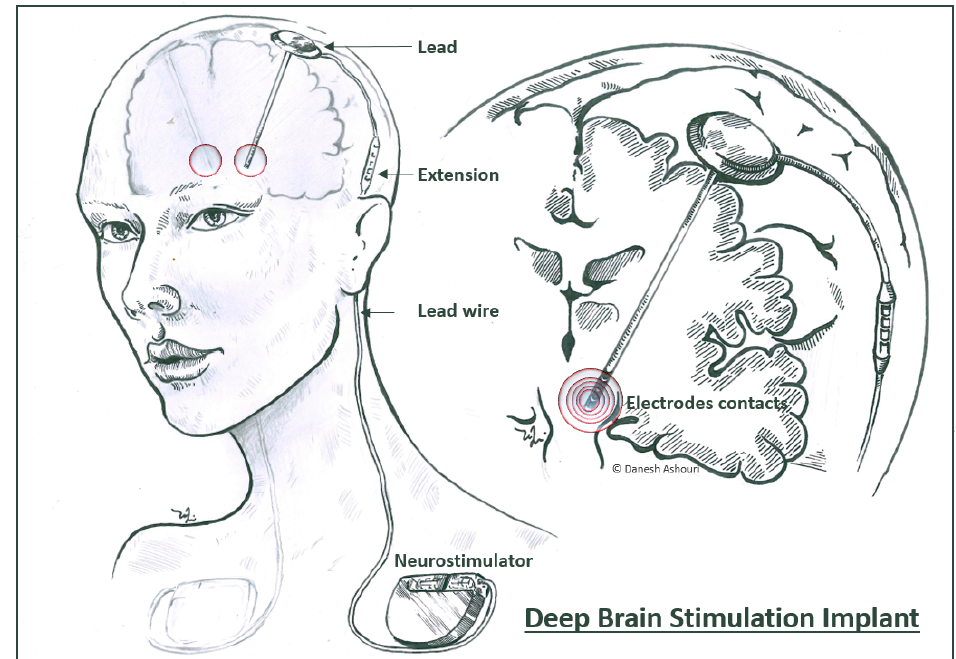
Figure 1. Illustration of a deep brain stimulation device implanted in a patient. A deep brain stimulation implant consists of four main components; electrode contacts, lead, lead wire, extension part and the implantable pulse generator (IPG or neurostimulator). A conventional DBS probe is featured with four annular active sites/contacts to deliver electrical current to the target tissue (diagram by D. Ashouri Vajari).